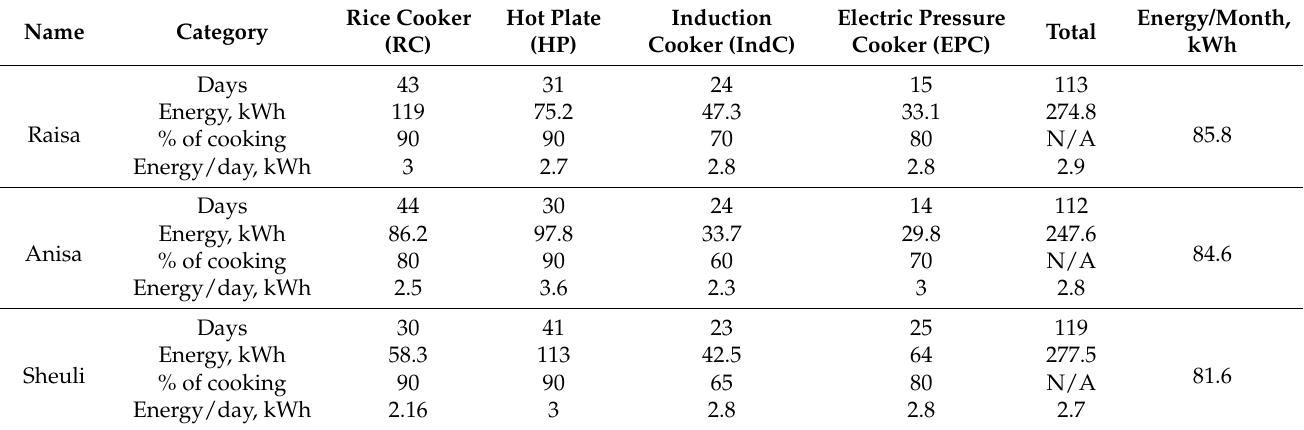
Table 3. Complied energy consumption